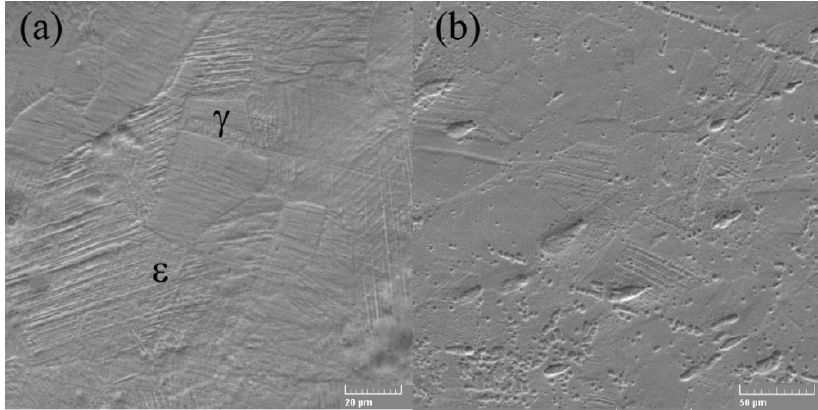
Figure 2. SEM micrographs of FeMnSi SMA ( a ) cast and ( b ) wrought. The γ / ε interfaces do not have the normal direction to the interface, present in the thermo-elastic martensitic transformations, for example, in the case of SMA based on Ti-Ni. In contrast, ε -martensite increases in the direction parallel to the γ / ε interfaces, and thickening occurs due to the coalescence of nearby thin ε plates. Microstructure analysis showed that ε -martensite has fine lamellar structures involving thin remaining layers and/or high probabilities of stacking defects [44]. Stacking failure inside ε -martensite is a thin plate with a thickness of two atomic layers. The appearance of the microstructure can be associated with the distribution of nucleation sites and the growth of martensite crystals; this increase in martensite occurs due to the displacement of partial Shockley dislocations [45]. The SME consists in the deformed state in which ε -martensite is induced as shown in Figure 3, which subsequently returns to the original γ —austenite shown